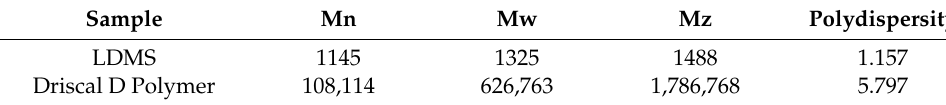
Figure 4. The molecular weight distribution of LDMS and Driscal. Table 1. Molecular weight and polydispersity of LDMS and Driscal.